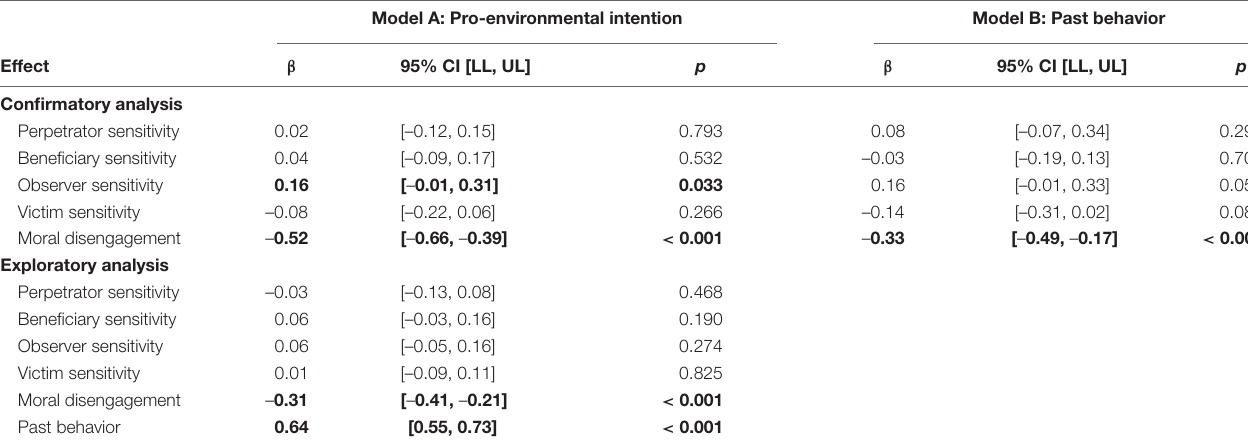
TABLE 3 | Regression analyses of pro-environmental intention and past pro-environmental behavior on justice sensitivity and moral disengagement in high carbon behavior in Study